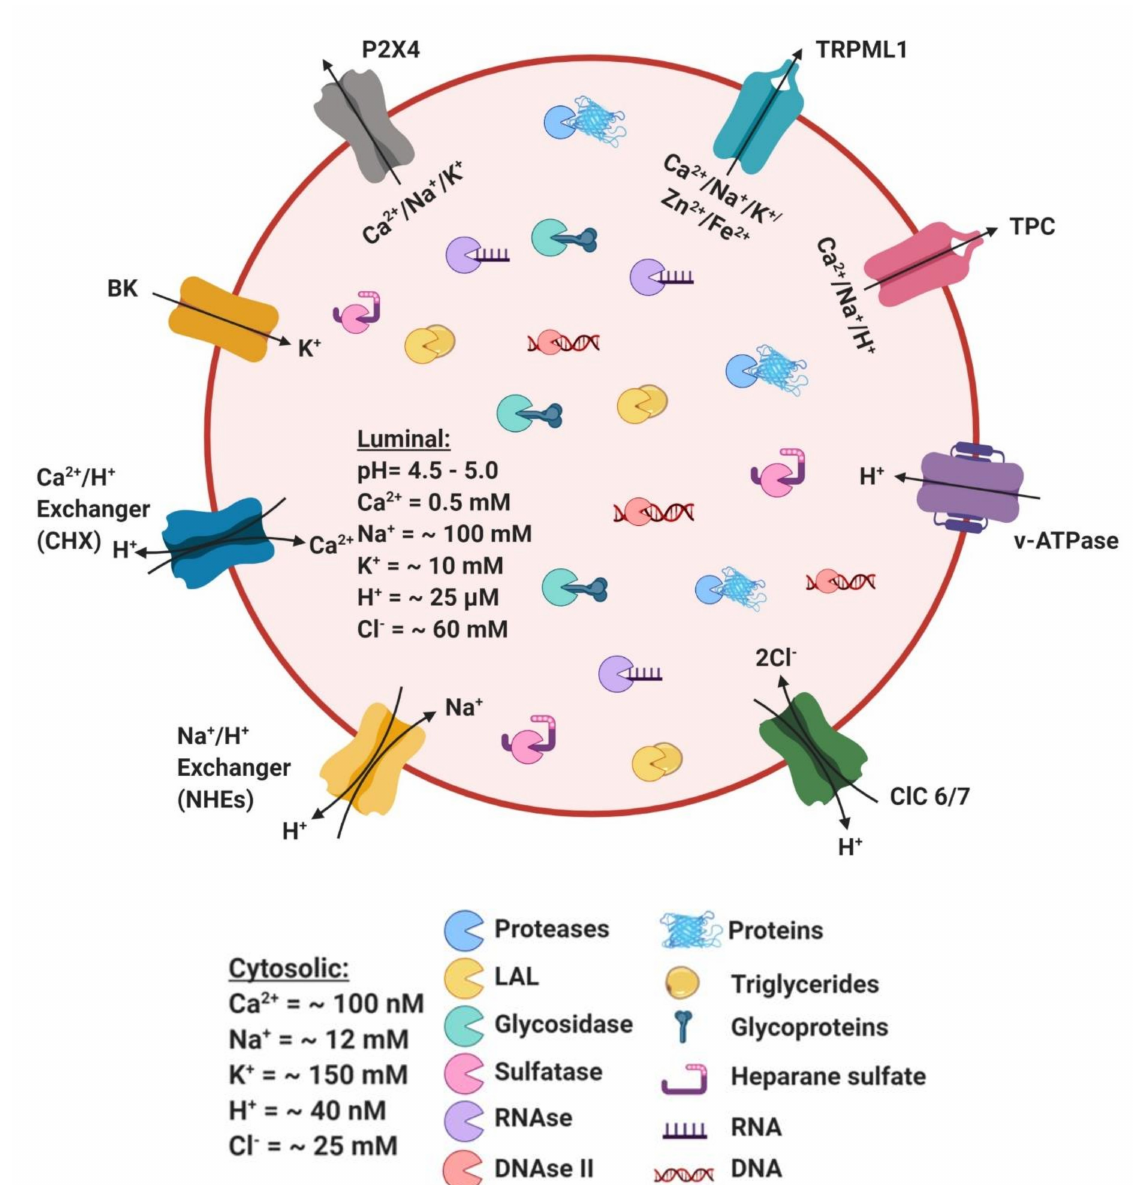
Figure 2. Lysosome ion channels and transporters. The lysosomal lumen contains a battery of soluble hydrolytic enzymes that degrade proteins (proteases), triglycerides (lysosomal acid lipase; LAL), glycoproteins (glycosidases), heparan sulphate (sulfatases), and nucleic acids (nucleases, RNAase and DNAse). Lysosomal ion channels and transporters include vATPase; vacuolar H + -ATPase (proton pump), chloride channel (ClC); ClC family that exchanges cytosolic Cl − for lysosomal H + (ClC-6 and ClC-7), K + channels (BK). Non-selective cation channels include Transient Receptor Potential Cation Channel (TRPML); permeable to Ca 2 + , Na + , K + , Zn 2 + and Fe 2 + , P2X4 channel; permeable to Ca 2 + , Na + and K + and two-pore channels (TPC); permeable to H + , Ca 2 + and Na + . Ion transporters include Na + / H + exchangers (NHEs) and Ca 2 + / H + exchangers